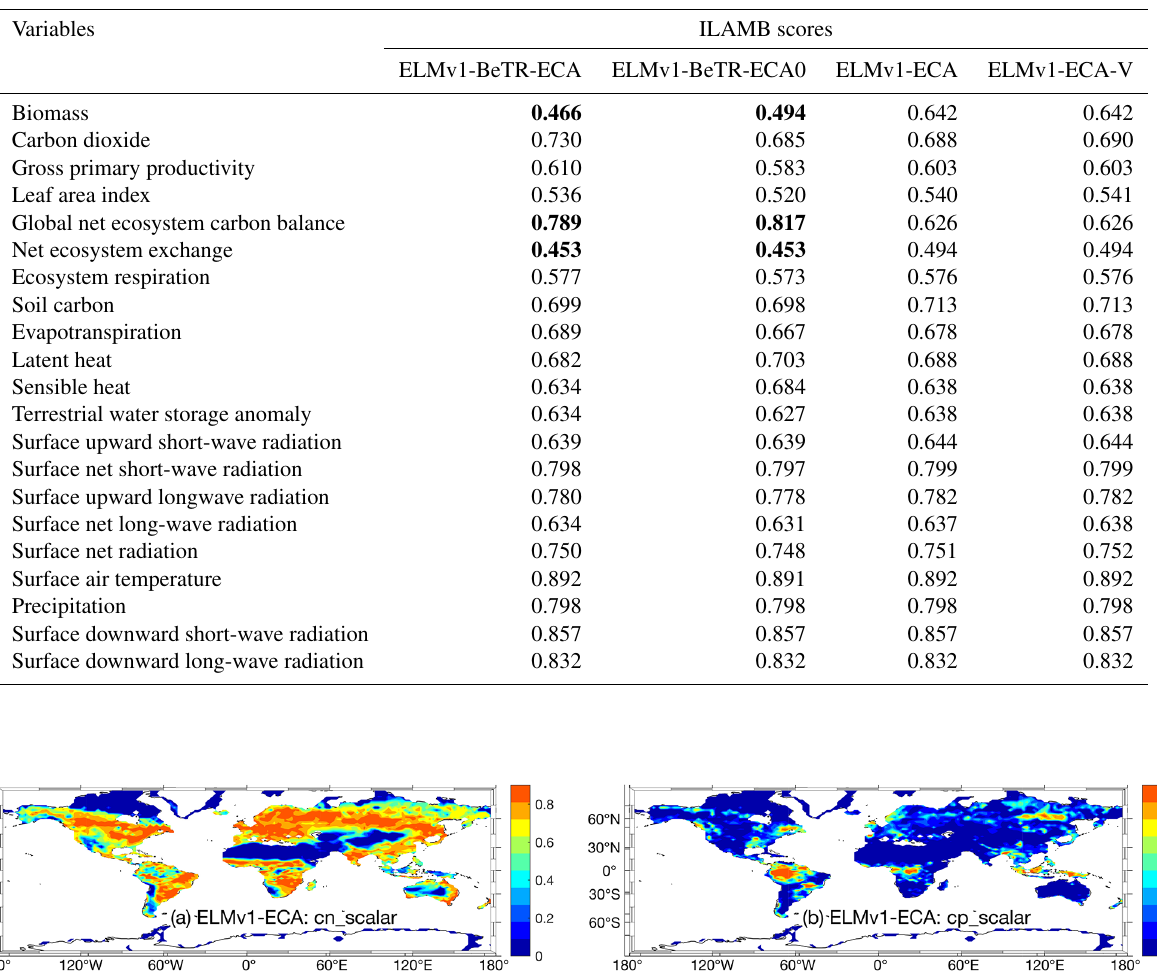
Table 3. Comparison of ILAMB scores for 23 simulated variables by three different model versions. The three entries in bold for ELMv1- BeTR-ECA (and ELMv1-BeTR-ECA0) differ by greater than 5% from ELMv1-ECA. All metrics are normalized to the range from 0 to 1, where greater values indicate better performance.